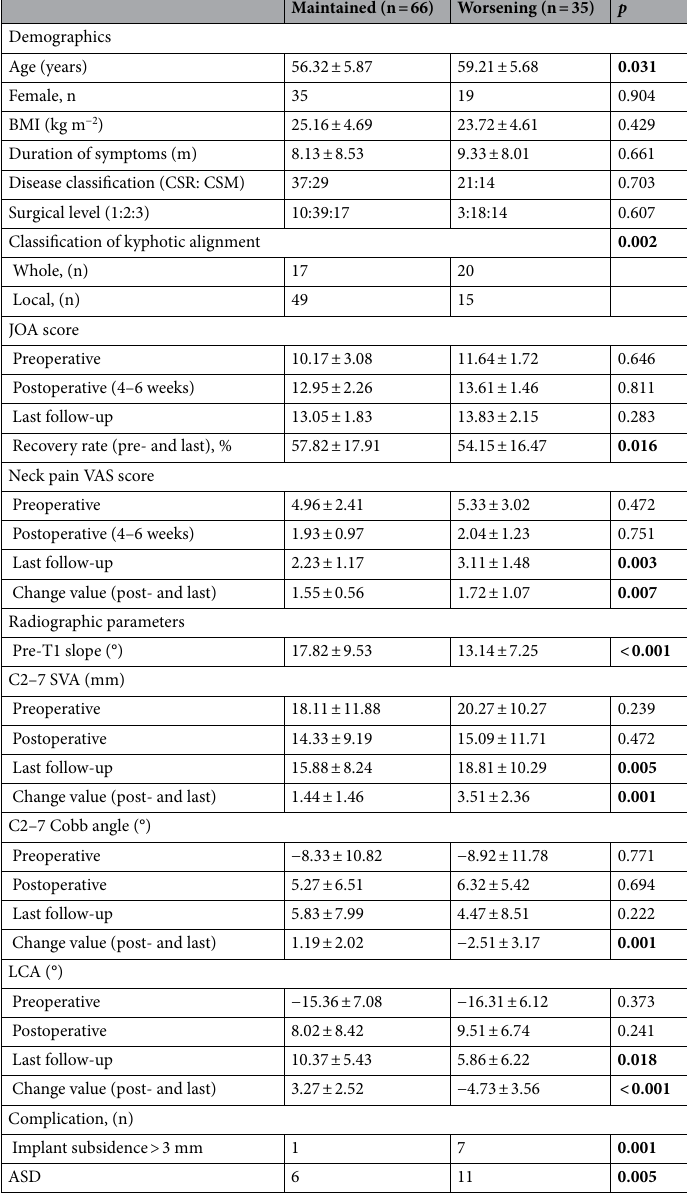
Table 3. Comparison of patient characteristics for the change of sagittal alignment after operation. BMI body mass index, CSR cervical spondylotic radiculopathy, CSM cervical spondylotic myelopathy, JOA